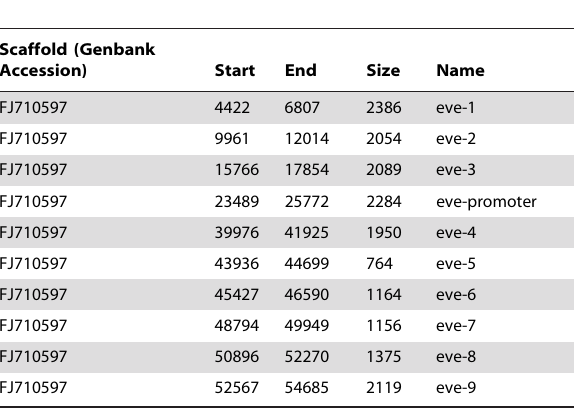
Table 3. Conserved non-coding sequenced in C. capitata even-skipped locus